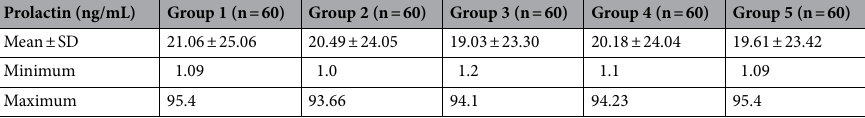
Table 2. Results of serum prolactin level for different groups in Phase 2 study.